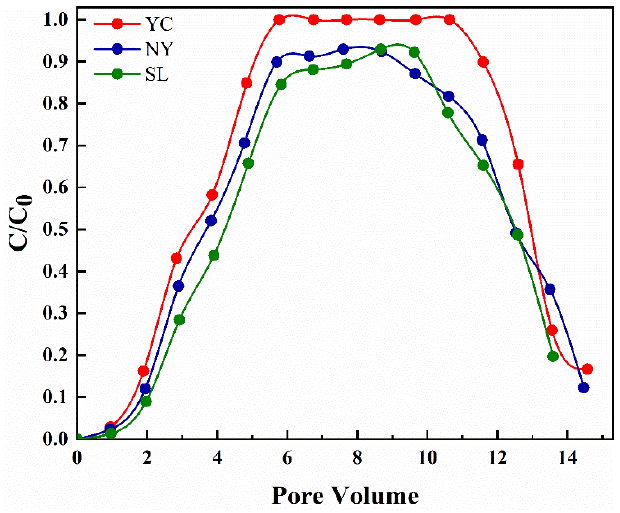
Figure 2. The influence of types of soil on vertical migration of phenanthrene (PHE).